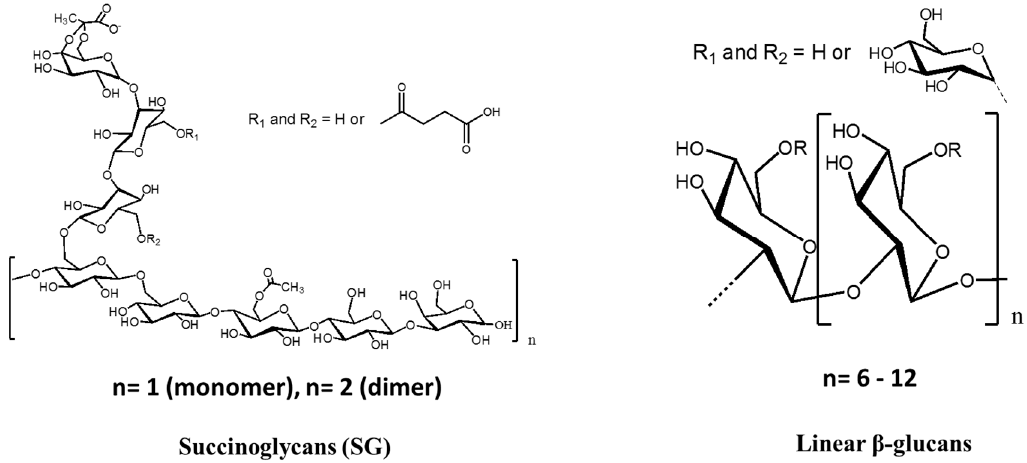
Figure 6. Structure of succinoglycan (SG) and liner β -glucans.